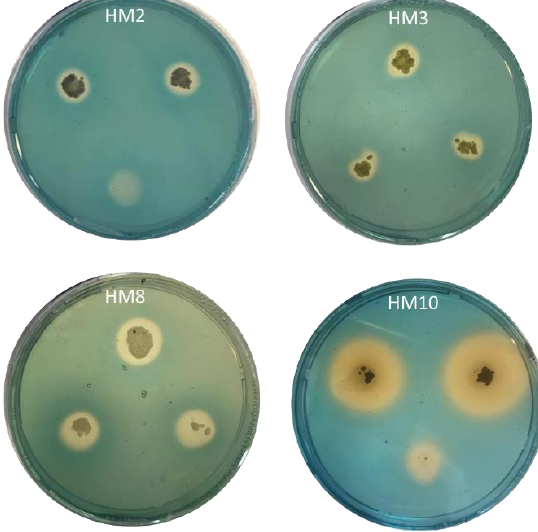
Figure 2. Siderophore production by the four Streptomyces strains detected in CAS–King’s blue agar medium. The orange-yellow halo around colonies represents siderophore production.